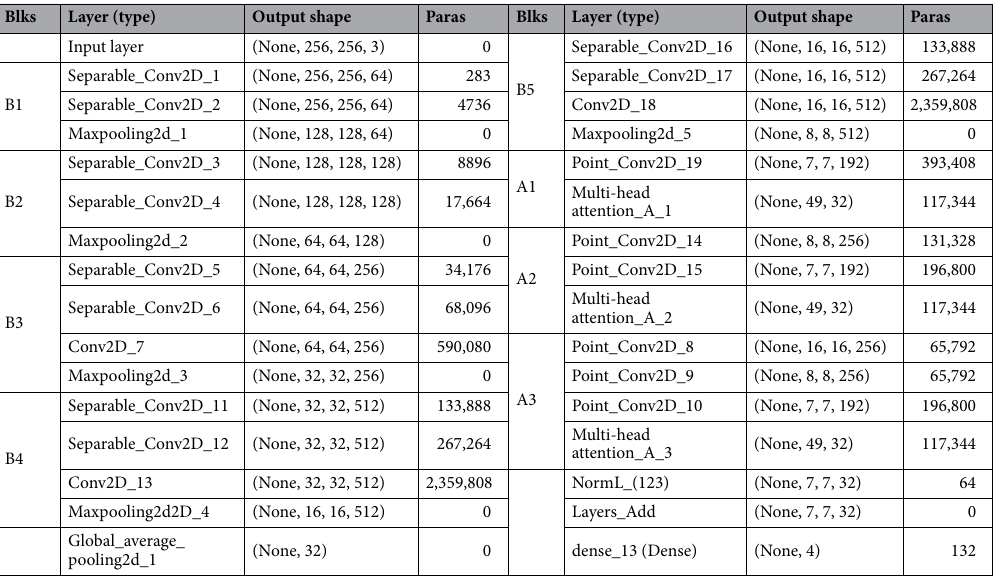
Table 1. Layer outputs and parameters of